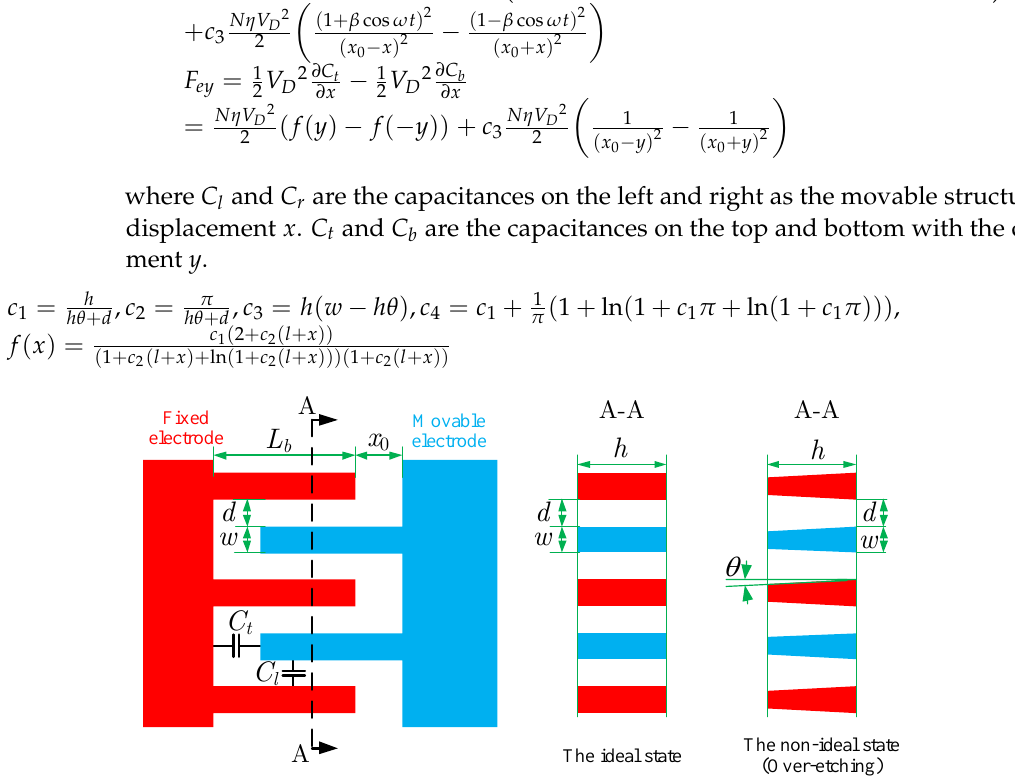
Figure 3. The capacitances and the inclination angle of the combs, where θ > 0 denotes the over- etching state and θ > 0 denotes the insufficient-etching